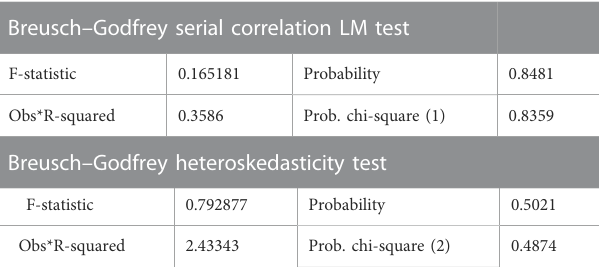
TABLE 6 Outcomes of the stability